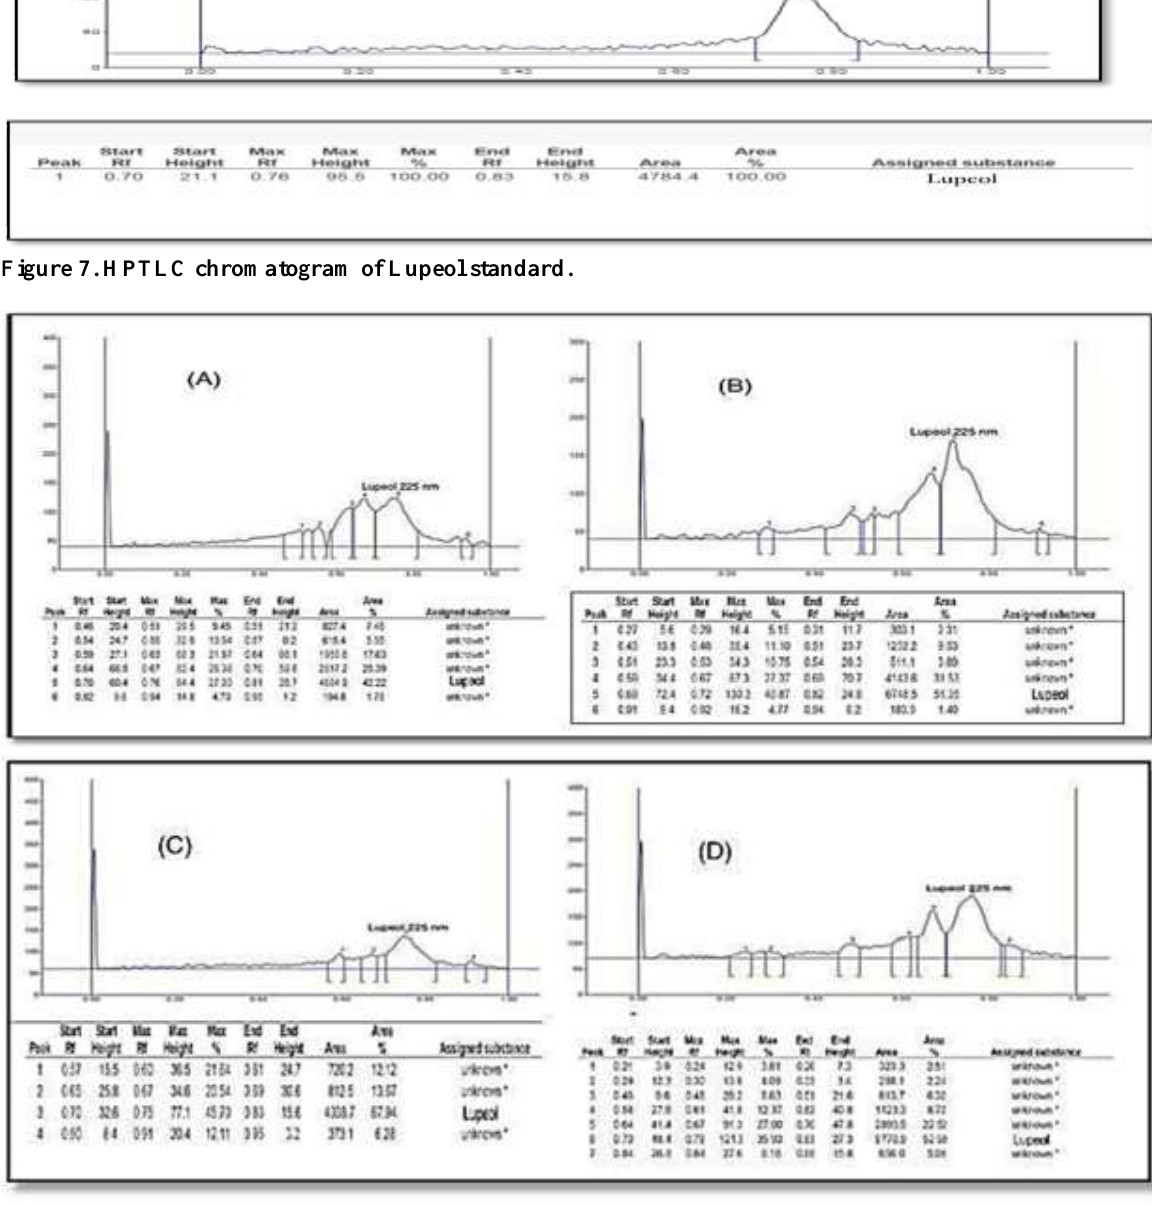
Figure 8. HPTLC chromatogram of Lupeol in petroleum ether fractions of leaves and stems of Leucaena leucocephala by hot and cold extraction methods. (A)Leaves, hot extraction method (B)Leaves, cold extrac- tion method (C)Stems, hot extraction method (D)Stems, cold extraction